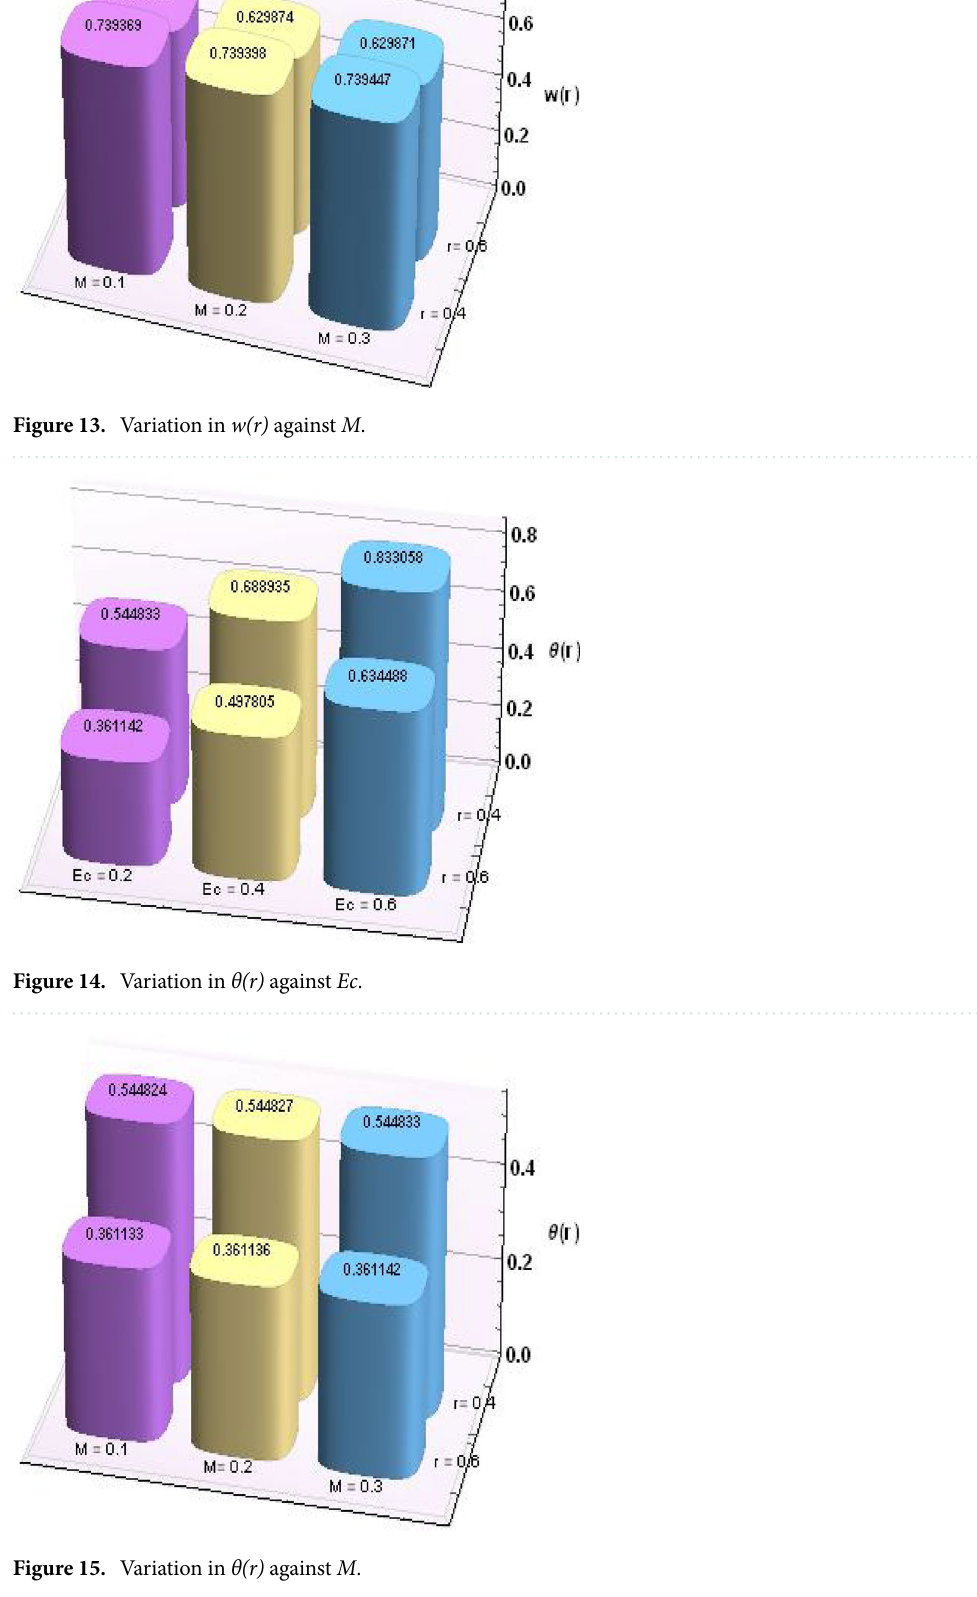
Figure 15. Variation in θ(r) against M